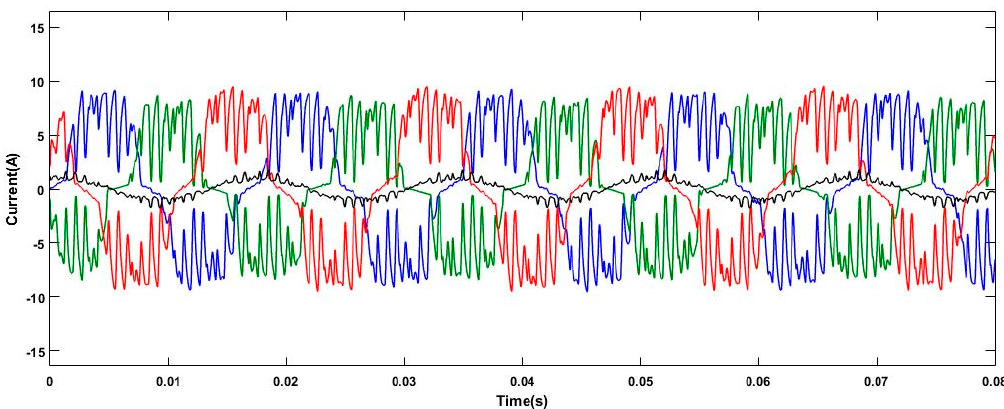
Figure 10. Source current without SAPF compensation for case 2.